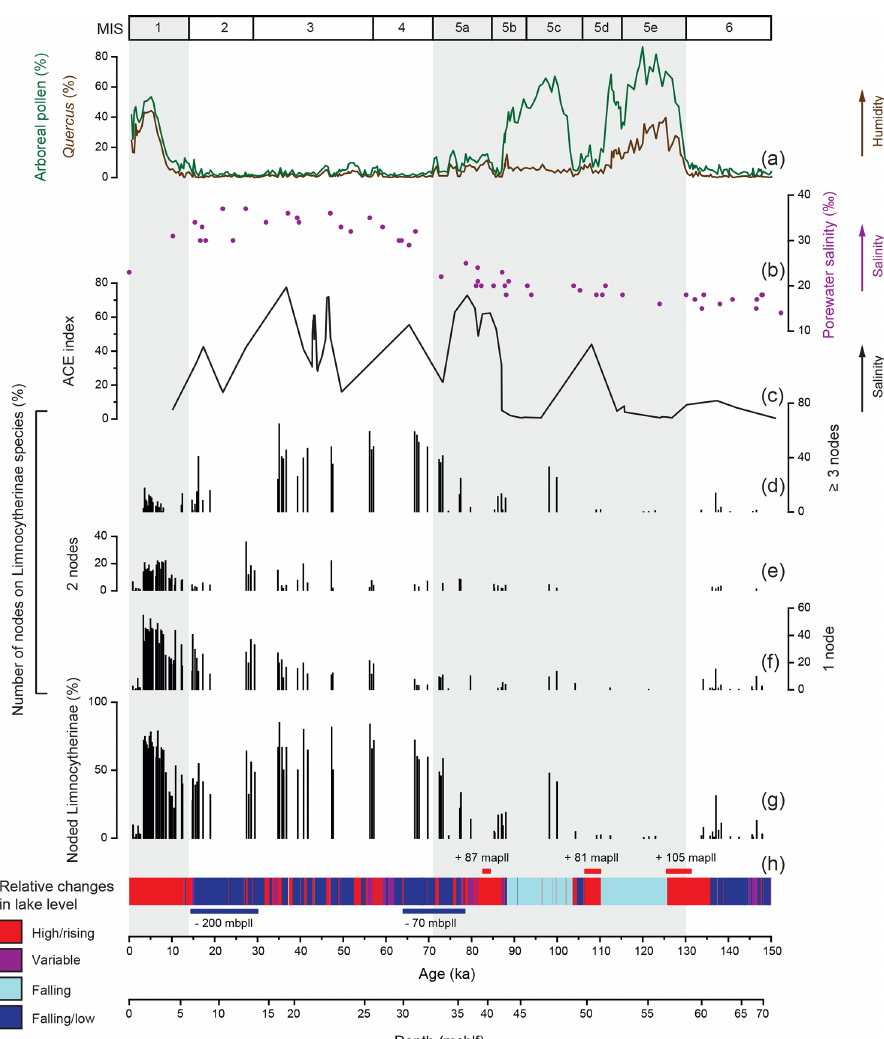
Figure 3. Amount and number of noded Limnocytherinae species valves relative to Lake Van palaeoenvironmental proxy records. Sedi- mentary proxies from Lake Van include (a) arboreal pollen and Quercus pollen percentage (Litt et al., 2014; Pickarski et al., 2015a, b; Pickarski and Litt, 2017), (b) porewater salinity plotted against depth in metres’ composite below lake floor (mcblf; Tomonaga et al., 2017), (c) biomarker Archaeol and Caldarchaeol Ecometric (ACE) index (Randlett et al., 2017) and (h) lithologies with genetic interpretations re- lated to lake level variability as a coloured bar (simplified according to Stockhecke et al., 2014a) and major lake level variations (Stockhecke et al., 2014a; Tomonaga et al., 2017). (d–f) Number of nodes in percent. (g) Total percentage of noded Limnocytherinae species. The grey shaded areas represent